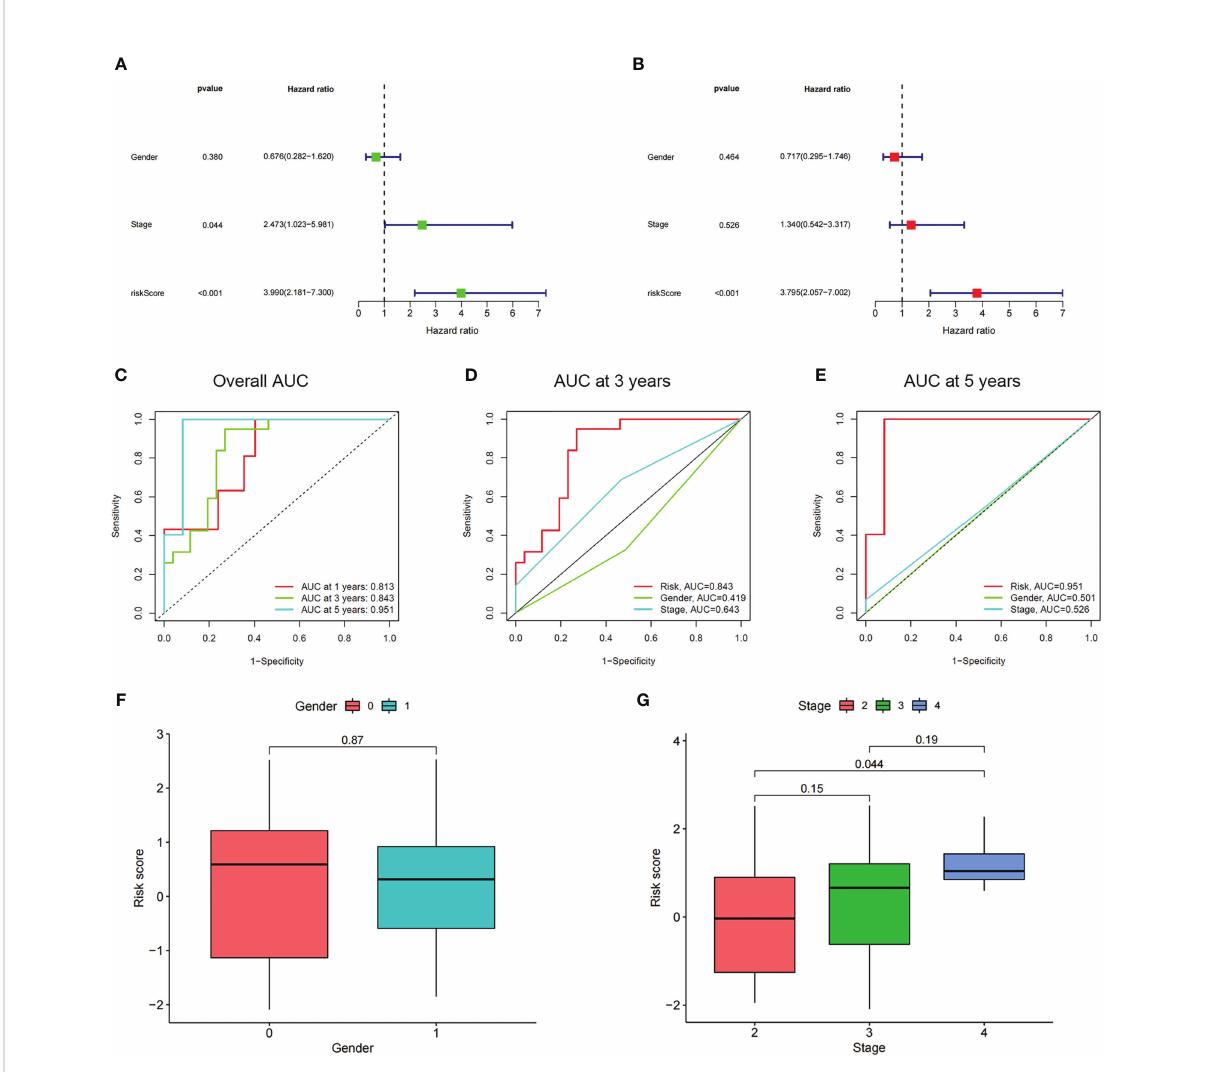
FIGURE 6 The prognostic value of the risk score and the association between risk score and clinicopathological factors. (A) Forest plot of the univariate Cox test to assess the correlation of risk scores and clinical factors with patient OS. (B) The forest plot of the multivariate Cox analysis identi fi ed independent prognostic factors associated with the OS of patients. (C-E) The ROC curve of risk score and clinical factors for predicting 1-, 3-, and 5-year OS in UM patients. (F, G) Distribution of ICD-related risk scores among UM patients strati fi ed by gender and stage in TCGA